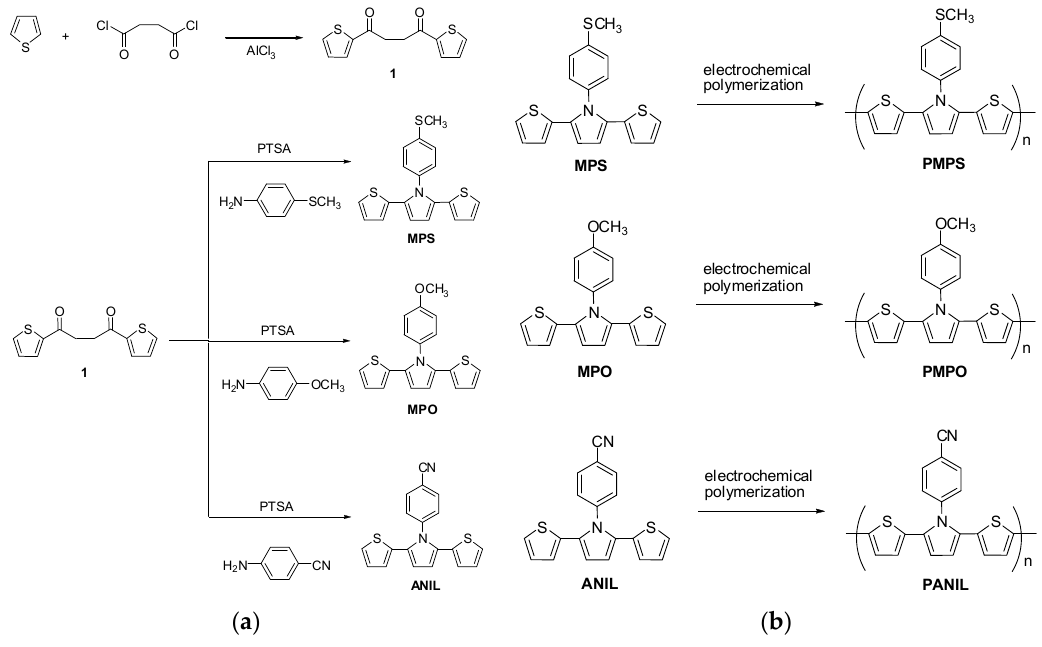
Figure 1. ( a ) The synthetic routes of poly(2,5-dithienylpyrrole) derivatives; ( b ) The electrochemical polymerization of poly(2,5-dithienylpyrrole) derivatives.